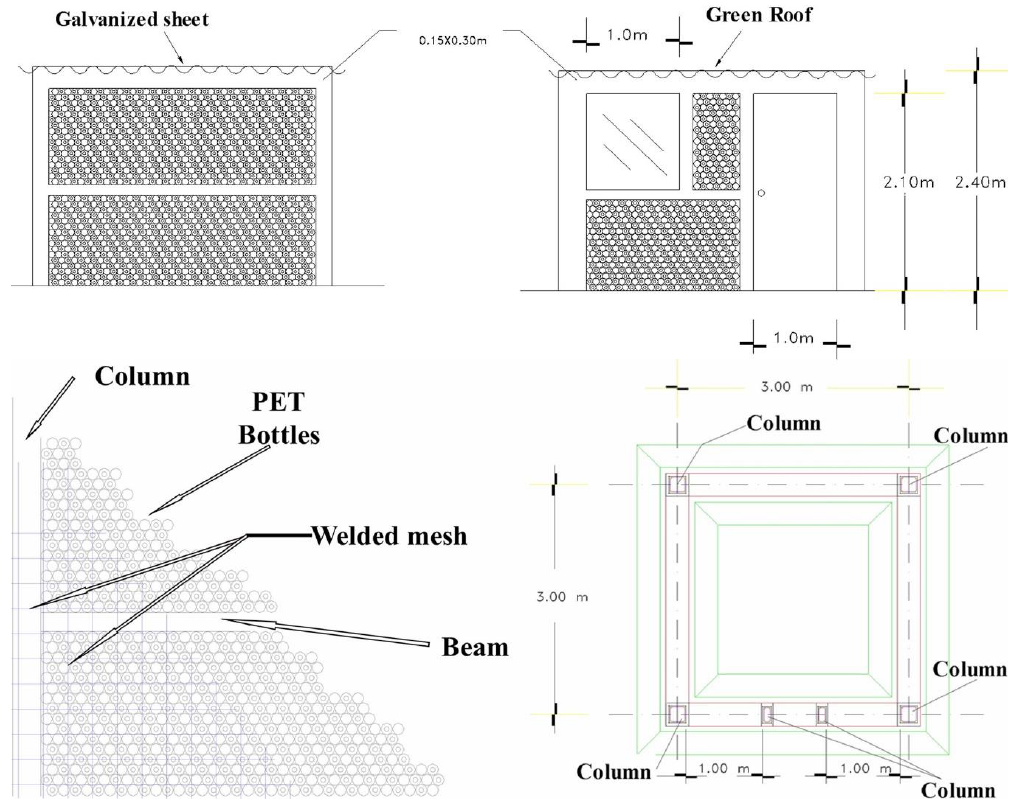
Figure 2. The structure planes proposed before constructing the housing.